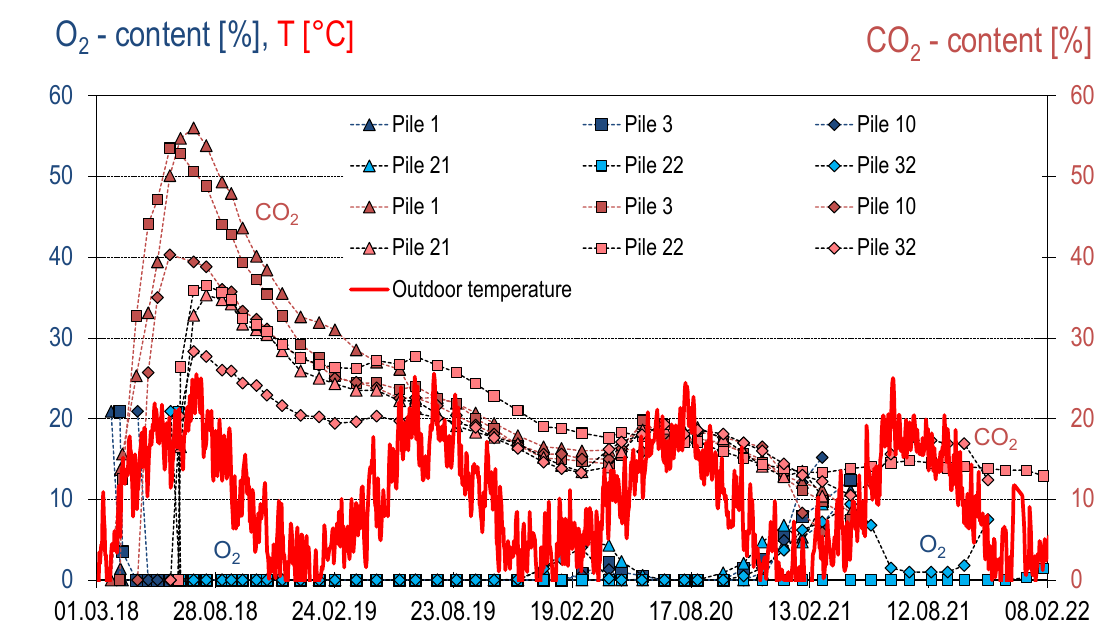
Figure 6. Comparison of the interior atmosphere of foil-packed piles set up early (April/May) and later in the year (June/July).